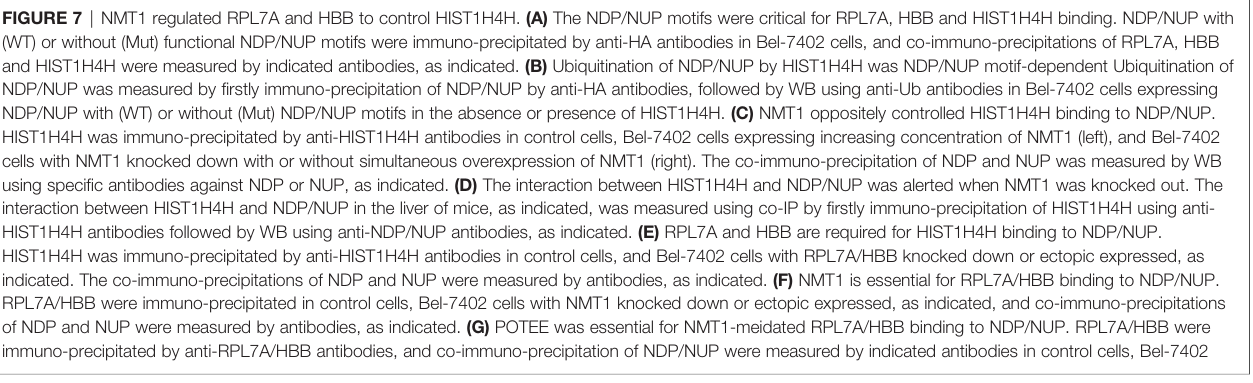
FIGURE 7 | NMT1 regulated RPL7A and HBB to control HIST1H4H. (A) The NDP/NUP motifs were critical for RPL7A, HBB and HIST1H4H binding. NDP/NUP with (WT) or without (Mut) functional NDP/NUP motifs were immuno-precipitated by anti-HA antibodies in Bel-7402 cells, and co-immuno-precipitations of RPL7A, HBB and HIST1H4H were measured by indicated antibodies, as indicated. (B) Ubiquitination of NDP/NUP by HIST1H4H was NDP/NUP motif-dependent Ubiquitination of NDP/NUP was measured by fi rstly immuno-precipitation of NDP/NUP by anti-HA antibodies, followed by WB using anti-Ub antibodies in Bel-7402 cells expressing NDP/NUP with (WT) or without (Mut) NDP/NUP motifs in the absence or presence of HIST1H4H. (C) NMT1 oppositely controlled HIST1H4H binding to NDP/NUP. HIST1H4H was immuno-precipitated by anti-HIST1H4H antibodies in control cells, Bel-7402 cells expressing increasing concentration of NMT1 (left), and Bel-7402 cells with NMT1 knocked down with or without simultaneous overexpression of NMT1 (right). The co-immuno-precipitation of NDP and NUP was measured by WB using speci fi c antibodies against NDP or NUP, as indicated. (D) The interaction between HIST1H4H and NDP/NUP was alerted when NMT1 was knocked out. The interaction between HIST1H4H and NDP/NUP in the liver of mice, as indicated, was measured using co-IP by fi rstly immuno-precipitation of HIST1H4H using anti- HIST1H4H antibodies followed by WB using anti-NDP/NUP antibodies, as indicated. (E) RPL7A and HBB are required for HIST1H4H binding to NDP/NUP. HIST1H4H was immuno-precipitated by anti-HIST1H4H antibodies in control cells, and Bel-7402 cells with RPL7A/HBB knocked down or ectopic expressed, as indicated. The co-immuno-precipitations of NDP and NUP were measured by antibodies, as indicated. (F) NMT1 is essential for RPL7A/HBB binding to NDP/NUP. RPL7A/HBB were immuno-precipitated in control cells, Bel-7402 cells with NMT1 knocked down or ectopic expressed, as indicated, and co-immuno-precipitations of NDP and NUP were measured by antibodies, as indicated. (G) POTEE was essential for NMT1-meidated RPL7A/HBB binding to NDP/NUP. RPL7A/HBB were immuno-precipitated by anti-RPL7A/HBB antibodies, and co-immuno-precipitation of NDP/NUP were measured by indicated antibodies in control